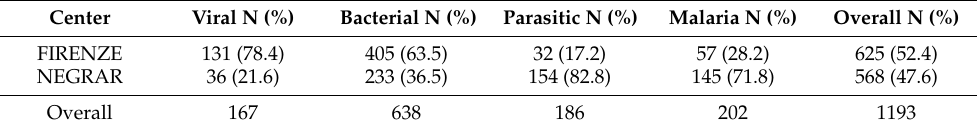
Table 2. Cases from the study site.